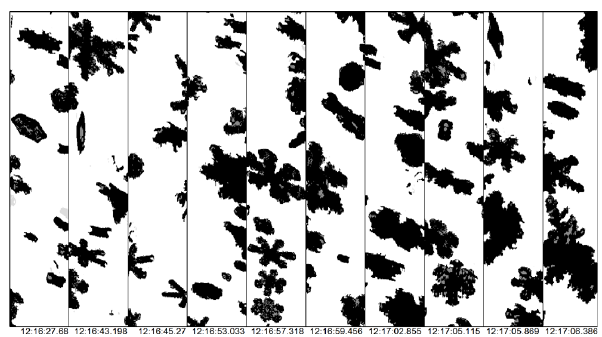
Fig. 11c. As Fig. 11a. Data are from R4 ( T =− 6 . 9 ◦ C, altitude = 2.88km) in the region of convective cloud encountered ap- proximately 20km west of CFARR.